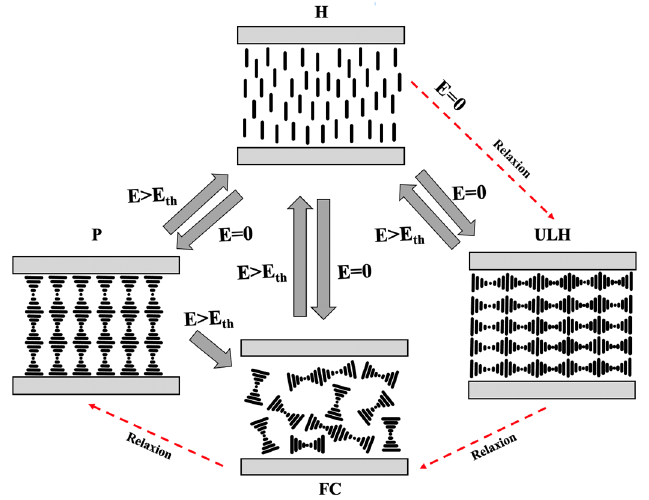
Figure 21. Schematic presentation of the structural transition in cholesterics. Transition from H to P state may involve transient ULH state in the relaxation process.